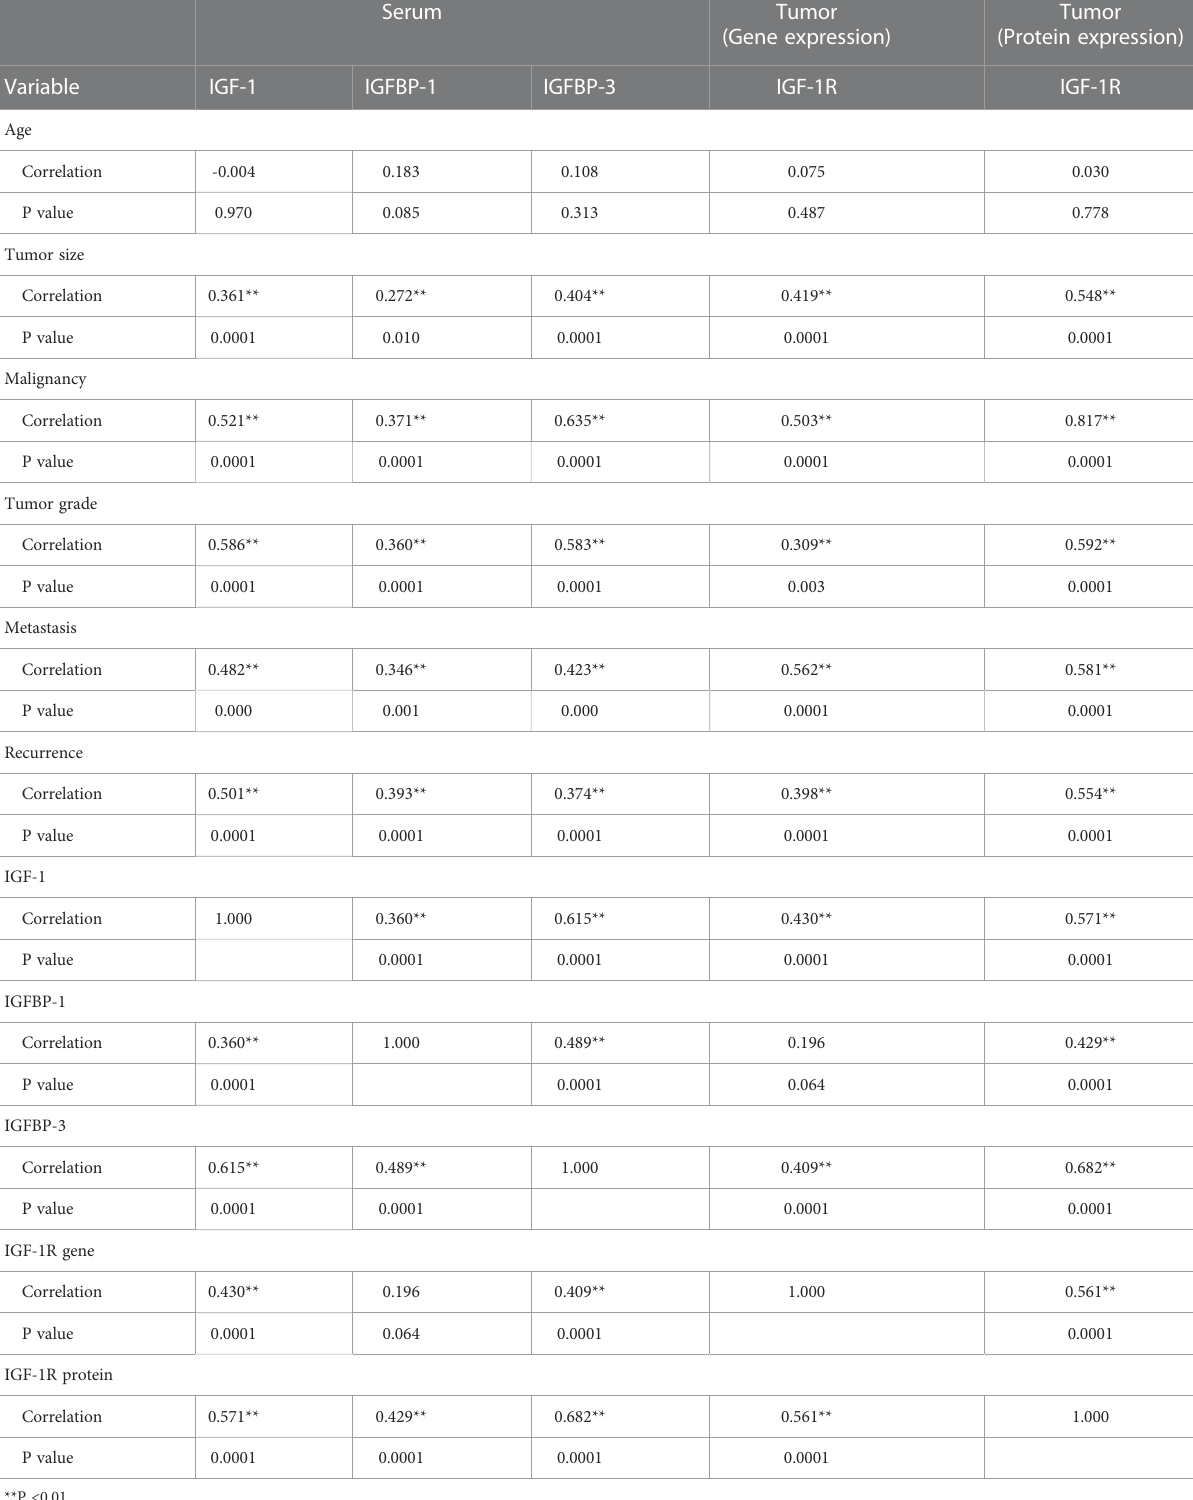
TABLE 2 The association of IGF-1, IGFBP-1, IGFBP-3 and IGF-1R with bone cancer different